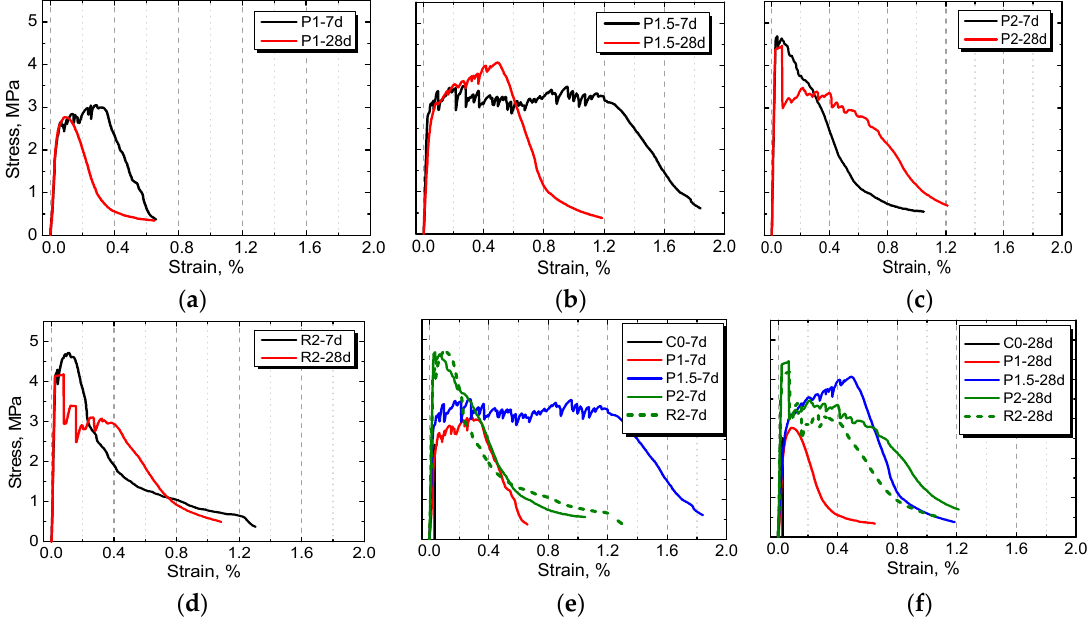
Figure 8. Tensile stress–strain behavior of NPFRCCs with di ff erent amount of fibers (( a ) P1, ( b ) P1.5, ( c ) P2 and ( d ) R2) and the comparison at ( e ) 7 days and ( f ) 28